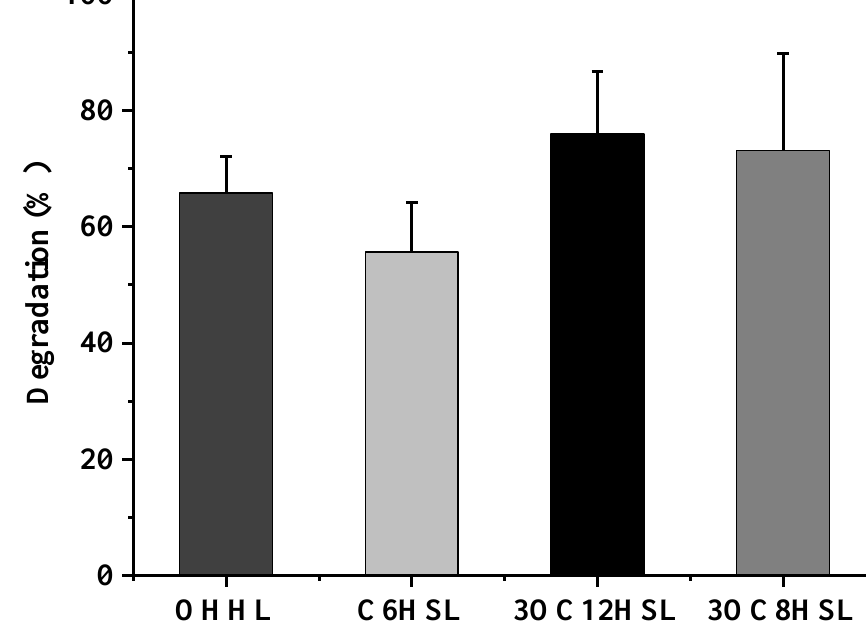
Figure 5. The degradation abilities of strain XN-10 to di ff erent AHL signal molecules. OHHL: N -(3 -oxohexanoyl)-L -homoserine lactone; C6HSL: N -hexanoyl-L-homoserine lactone; 3OC12HSL: N -(3 -oxododecanoyl)-L-homoserine lactone; 3OC8HSL: N -(3-oxooctanoyl)-L-homoserine